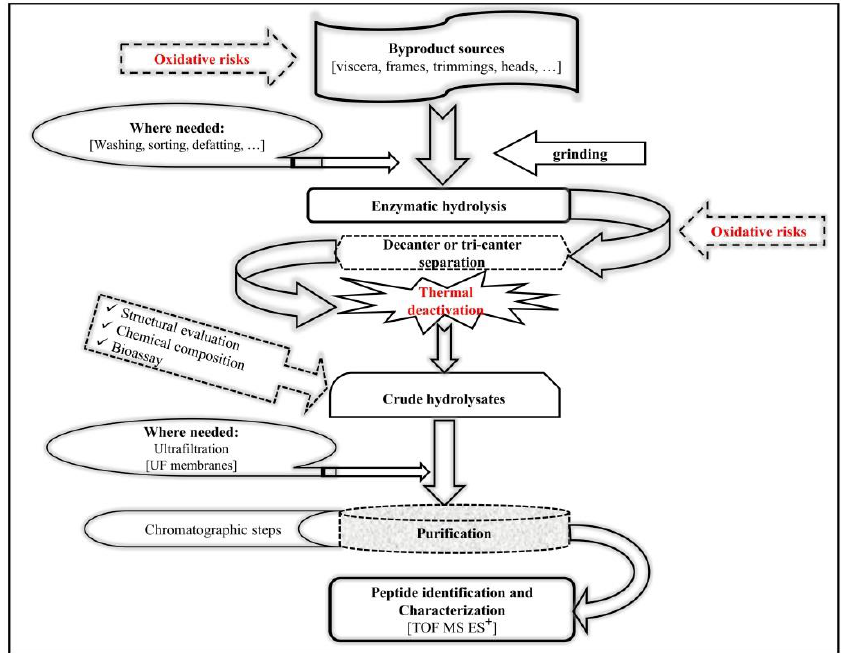
Figure 1. Schematic figure for enzymatic hydrolysis of byproducts of the seafood industry. Enzymatic hydrolysis is done with the aid of proteolytic enzymes such as endopep- tidases that cleave the peptide bonds within polypeptide chains, and exopeptidases that break peptide bonds from the end of the protein chain. Each protease has a unique specificity for peptide bonds adjacent to certain amino acid residues [6]. Proteases of micro- bial (Alcalase, Flavourzyme, and Neutrase), plant (papain, bromelain, and ficin), or fish (pepsin, trypsin, and chymotrypsin) origin have been used for the enzymatic hydrolysis of byproducts. Microbial proteases have been used for producing FPH from various seafood byproducts due to their higher efficiency in hydrolyzing protein substrates at higher pH with more temperature stability [26,27,30]. The use of commercial enzymes is generally required to obtain peptides for food applications because of the greater control of the process compared to autolytic hydrolysis, which may be used when the final aim is to prepare feed ingredients with somewhat less stringent requirements [36,45].